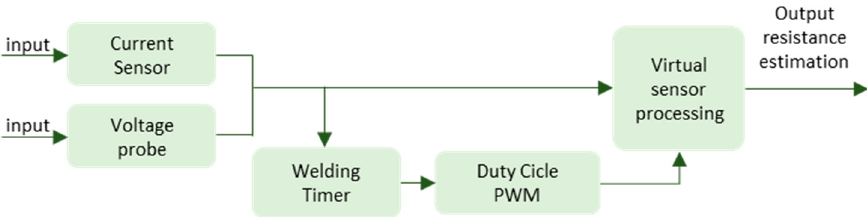
Figure 4. Conceptual summary of the virtual sensor for the estimation of the resistance of the secondary.